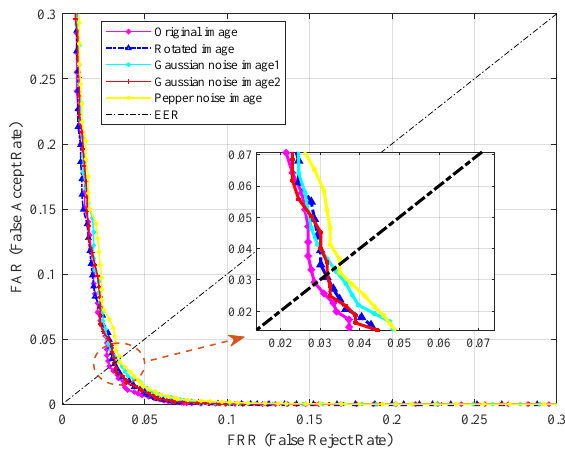
Figure 7. Robustness